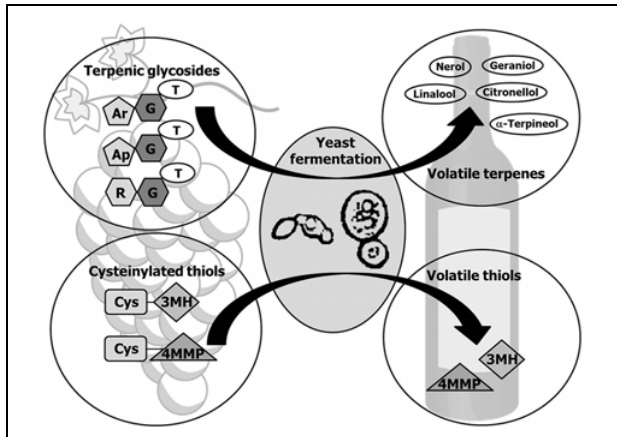
FIGURE 2 | Release of primary aroma compounds by yeasts. Monoterpenes and volatile thiols occur in grape as odorless precursors which can be released by enzymatic activities of Saccharomyces and non- Saccharomyces yeasts during fermentation. Monoterpene glycosides are mainly glucosides and diglycosides, in which the glucose moiety (G) has been further substituted mainly with arabinose (Ar), apiose (Ap), or rhamnose (R). A two-step enzyme-catalyzed reaction is the main mechanism proposed for the enzymatic hydrolysis of the diglycosides and subsequent release of the free volatile terpene (T) to wine. First a specific glycosidase cleaves the linkage between both sugars and in a second step the released glucoside is hydrolyzed by a β - D -glucosidase, liberating glucose and the corresponding terpene. Volatile thiols are generated from the odourless cysteinylated precursors cysteine-3-mercaptohexan-1-ol (Cys-3MH) and cysteine-4-mercapto-4-methylpentan-2-one (Cys-4MMP) by the action of